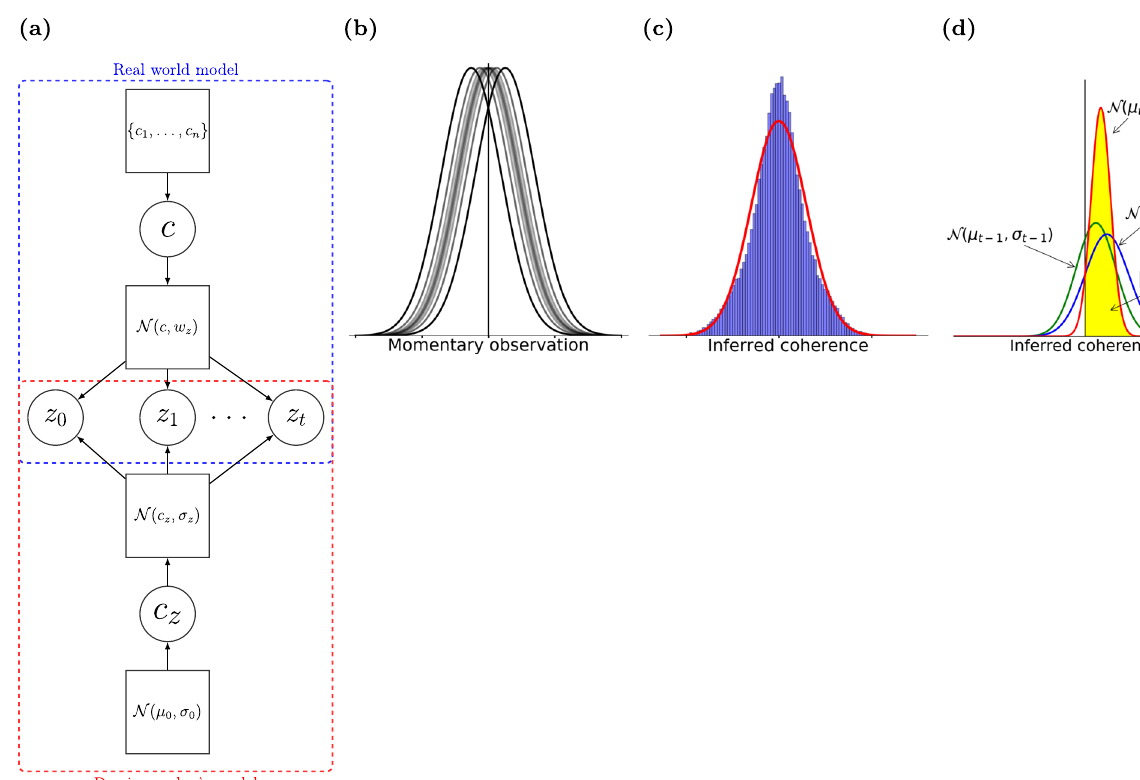
Fig. 2 The POMDP model of the direction discrimination task. a Our modeling framework depicting the real world generative model and the decision maker ’ s model. In each trial, the state (here signed coherence c ) is generated from a prior (here a discrete set selected by the experimenter). Given a value for c for a trial, all of the observations z i in that trial are independent samples generated from an observation function ( N ð μ ¼ c ; w z Þ ). While the decision maker has full access to the observations, the prior distribution and the observation function are not known. Our POMDP model estimates these two ¼ 0 ; σ Þ and N ð c ; σ Þ where σ σ z are learned from data (see text), and c z is the coherence which is estimated by the subject distributions as N ð μ z z 0 and 0 0 using the belief N ð μ t ; σ t Þ as described in the text. b Probability distribution of momentary observations for a motion coherence c is modeled as a Gaussian distribution with mean μ = c and variance w 2 z . There are multiple Gaussian distributions for different motion coherences. Positive and negative observations indicate rightward and leftward motion directions, respectively. c The distribution of inferred coherence across all trials provides the initial belief state of the POMDP model (blue histogram) at the beginning of each trial. The initial belief is approximated by a Gaussian function (red curve). d The POMDP model sequentially updates its belief about the motion coherence based on new observations. Combining the belief at time t − 1 (green distribution) with the acquired observation from the stimulus at time t (blue distribution) results in a new belief at t (red distribution). The expected likelihood that the rightward choice is correct is the area under the updated belief distribution for positive sensory evidence (yellow region).